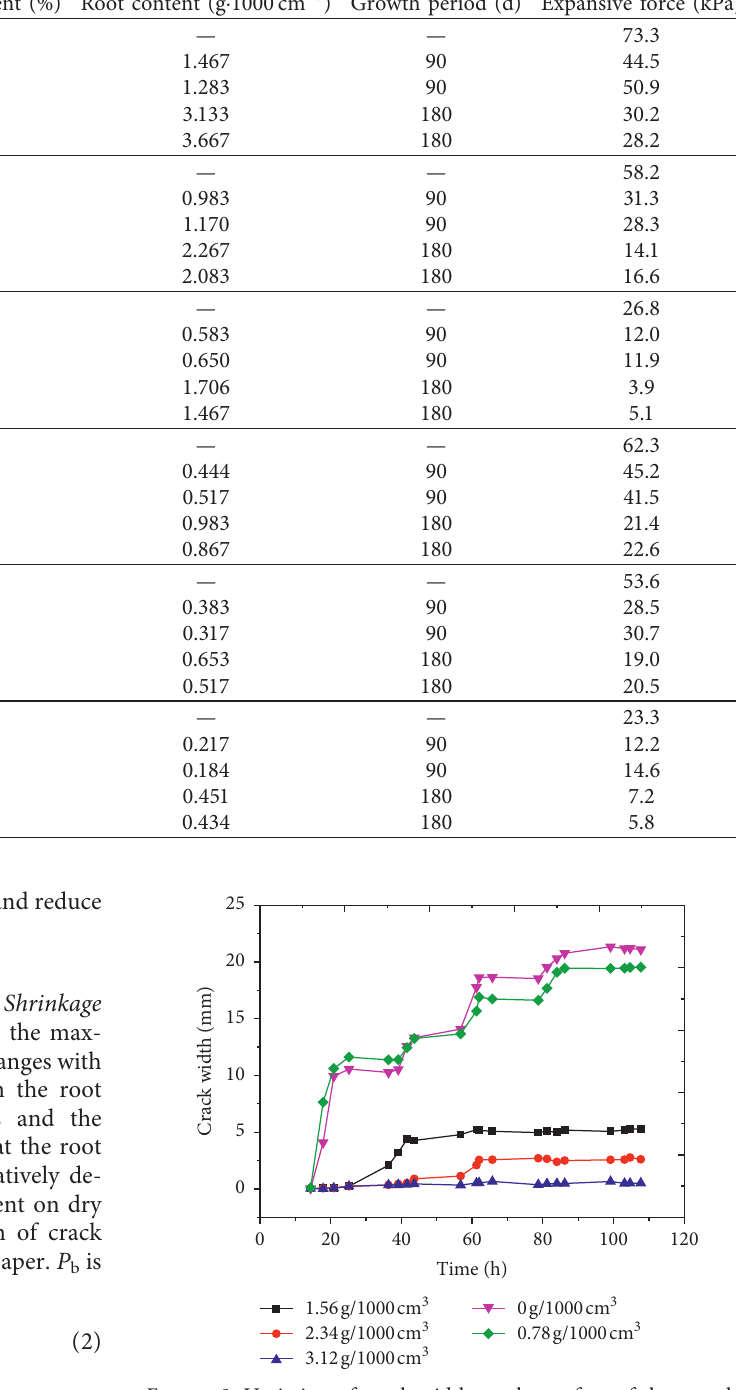
Figure 9: Variation of crack width on the surface of the